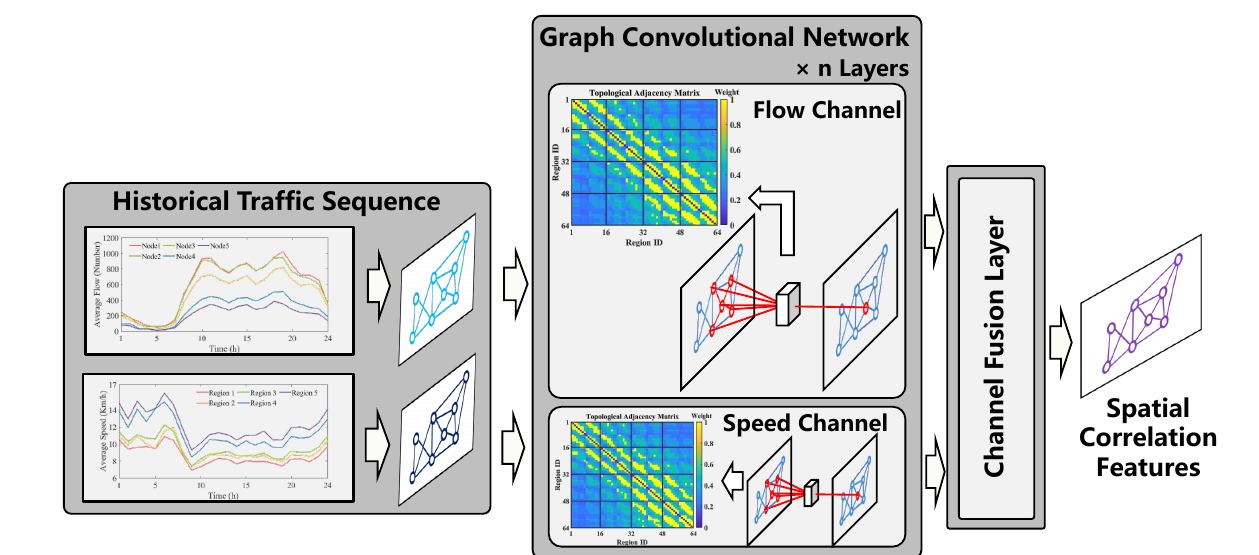
Figure 6. The process of spatial correlation modeling.